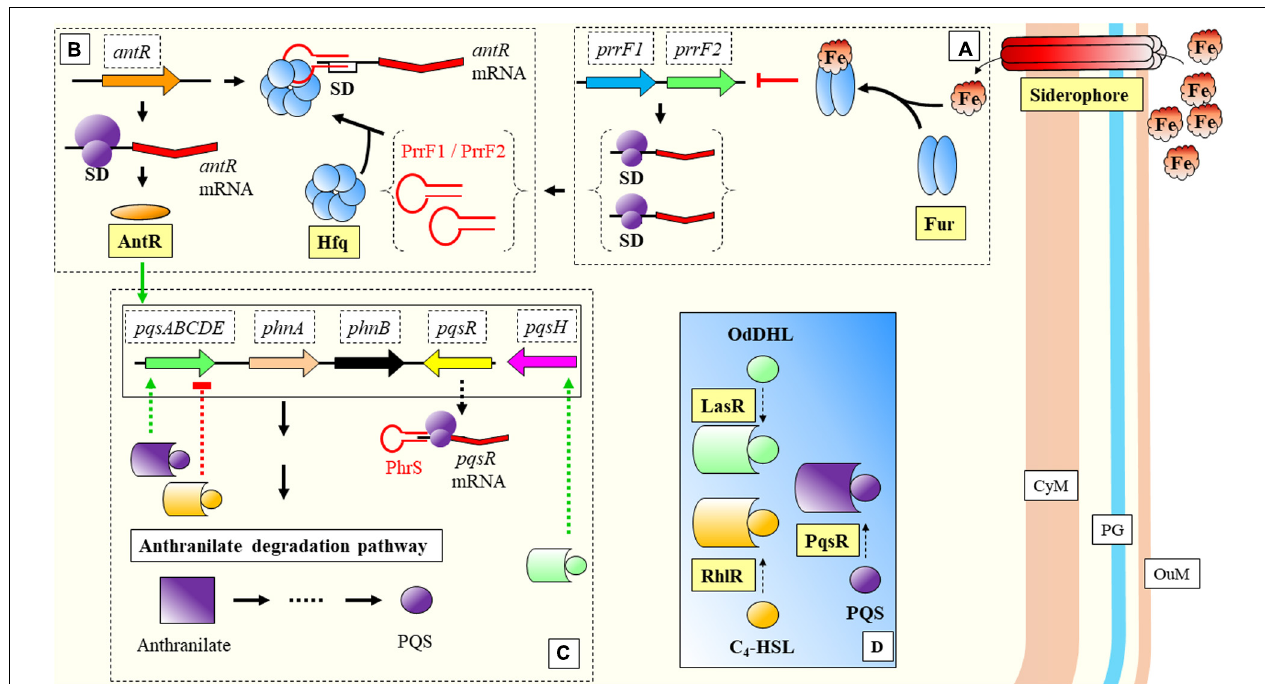
FIGURE 5 | Nutritional immunity response in Pseudomonas aeruginosa . (A) Excess of extracellular iron is bound to Fur protein that inhibits transcription of PrrF1 and PrrF2. (B) PrrF1 and PrfF2 bind to the SD site by mediation of Hfq and block the translation of antR. (C) AntR has a positive effect over anthranilate degradation genes. Another sRNA, PhrS, allows the transcription of pqsR . (D) PqsR is an important regulator, which together with RhlR and LasR have key regulatory effects over genes belonging to the anthranilate degradation pathway (shown in panel C ). CyM, Cytoplasmic membrane, OuM, Outer membrane; PG, peptidoglycan. Black thick arrows indicate flow of a biological process, e.g., protein translation. Green thick arrows indicate activation (equal for green thick dashed lines). Red thick arrows with flat cap indicate inhibition (equal for red thick dashed lines). References: Dubern and Diggle, 2008; Brouwer et al., 2014; Baker et al., 2017; Djapgne et al.,